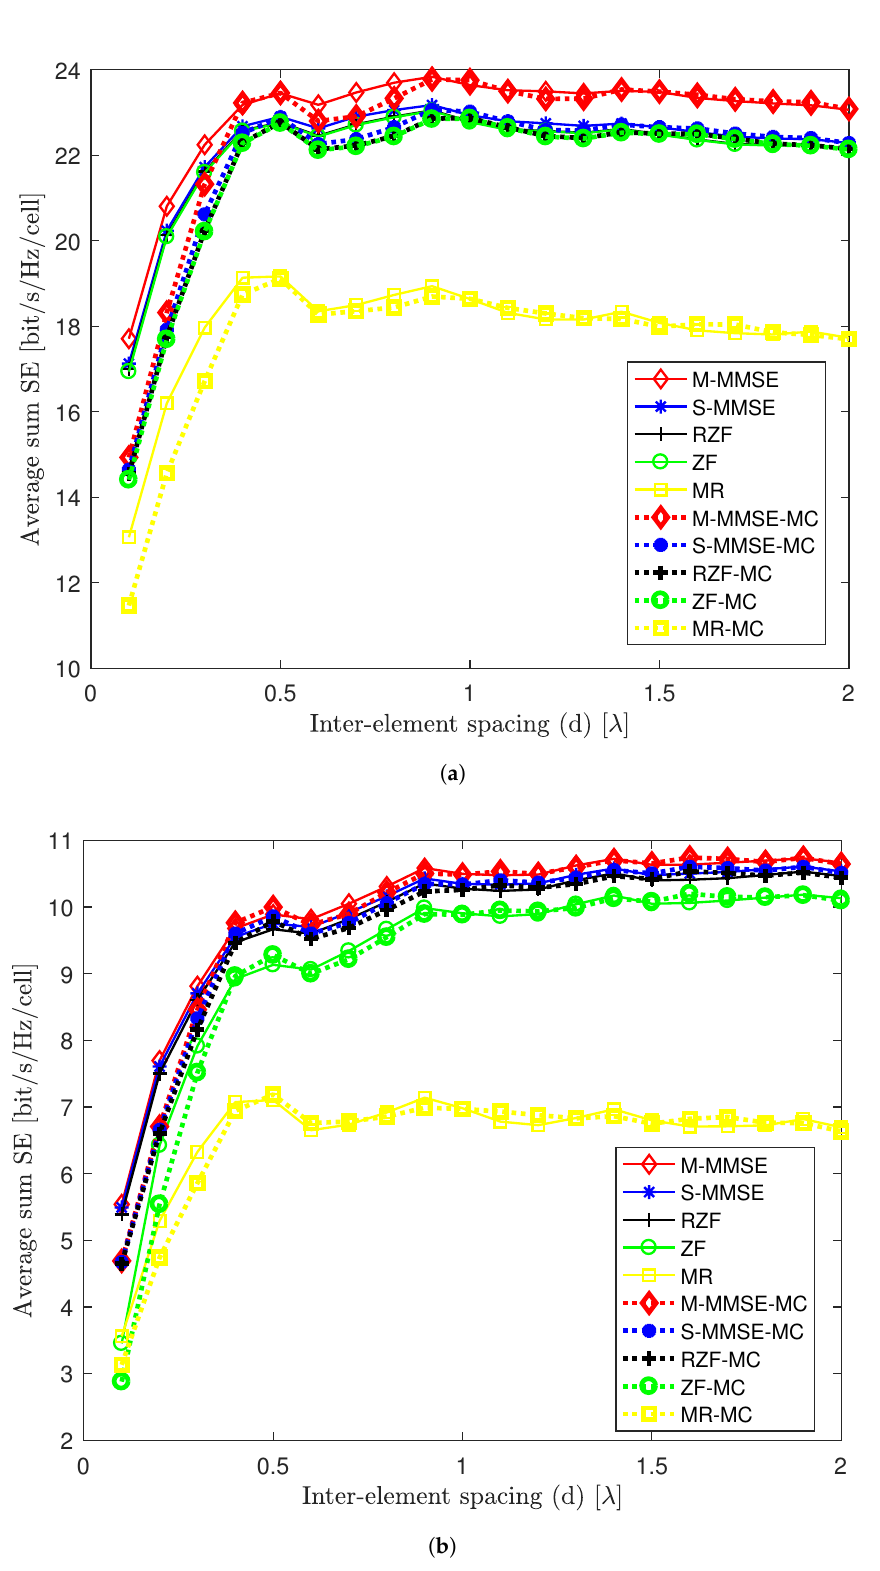
Figure 2. Spectral efficiency comparison of different algorithms with and without mutual coupling vs. inter-element spacing d when the number of antenna elements ( a ) N = 200, ( b ) N =